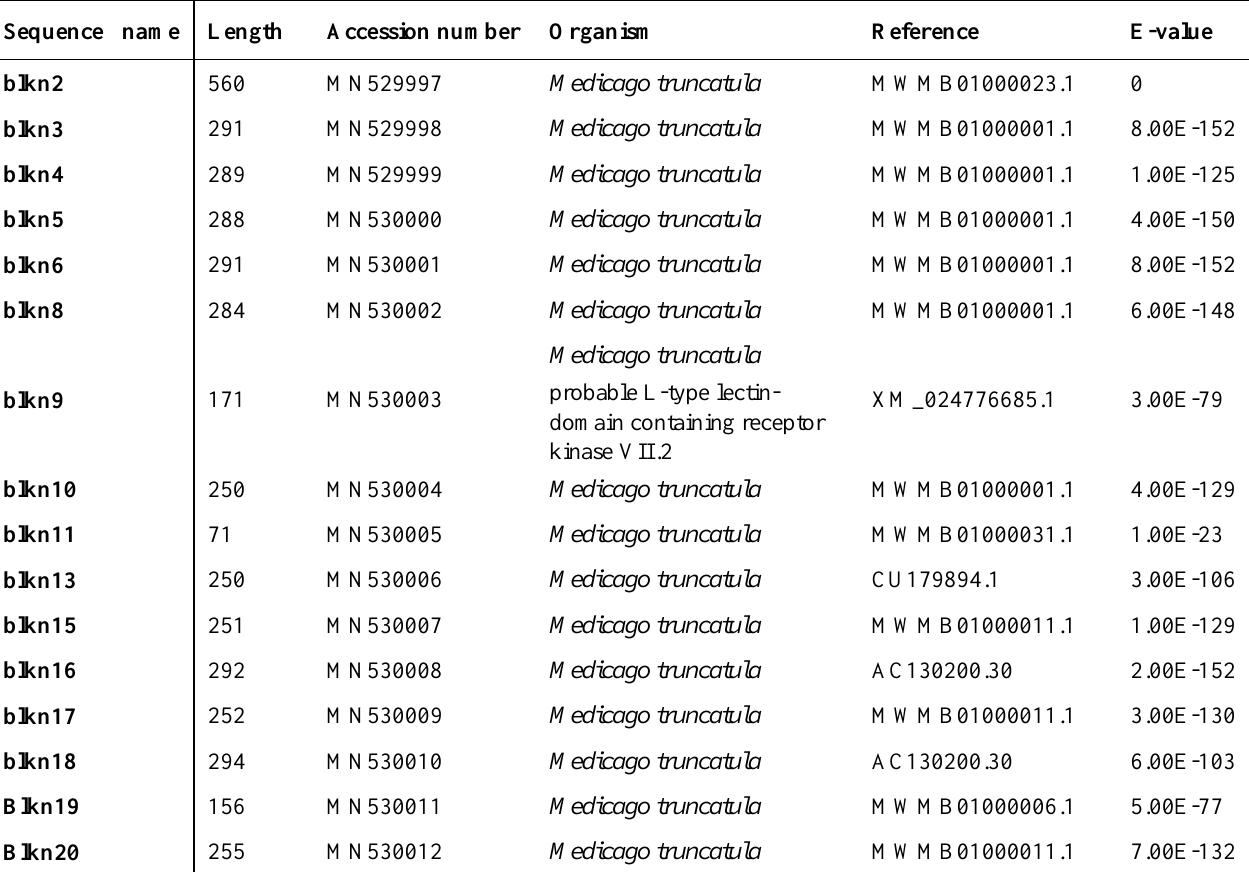
Table1: blkn Tnt1 -tagged